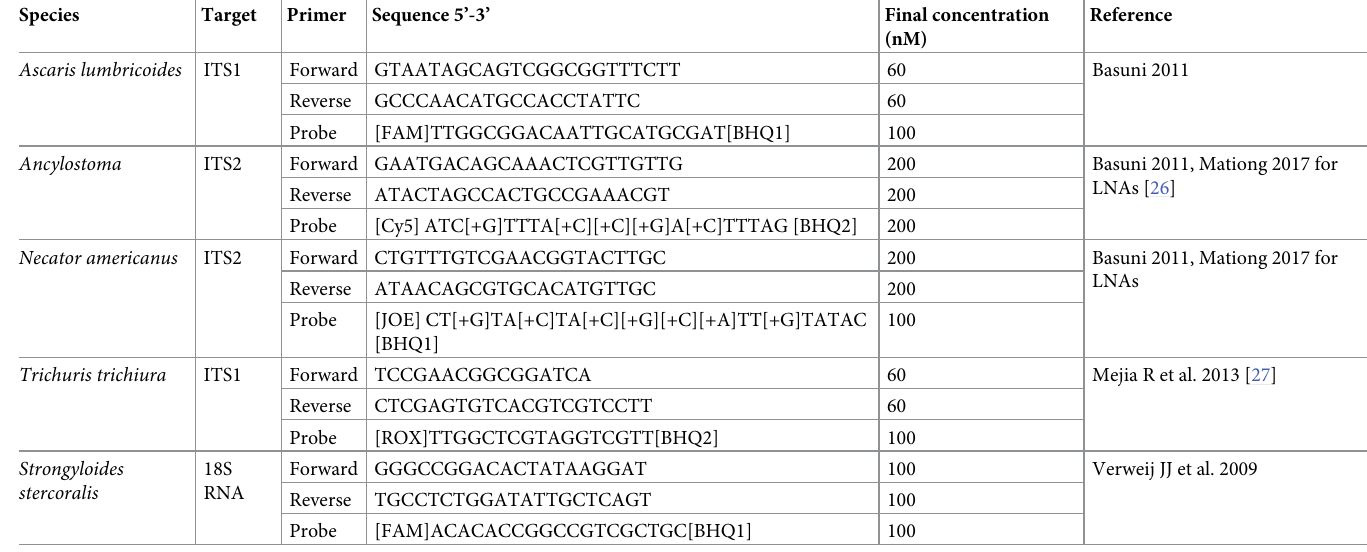
Table 1. Primer and probe sequences used in qPCR detection of STH in stool DNA. Bases in brackets and indicated by a + are locked nucleic acids. S . stercoralis was run separately while the other four species were multiplexed.